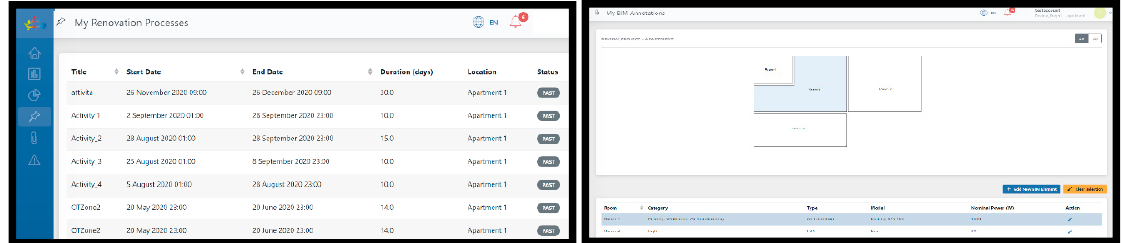
Figure 3. Building Occupant Renovation App Views: renovation tasks scheduling & BIM elements annotation.